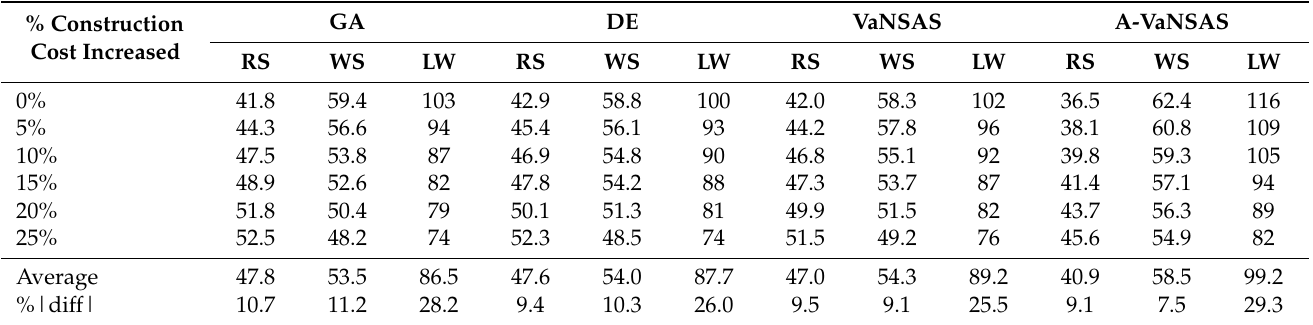
Figure 7. Comparison of drought risk in Khong Chiam ( A ) when budget reduction of 0% and ( B ) 50%. Table 6. Total risk and LW of the proposed methods using different construction